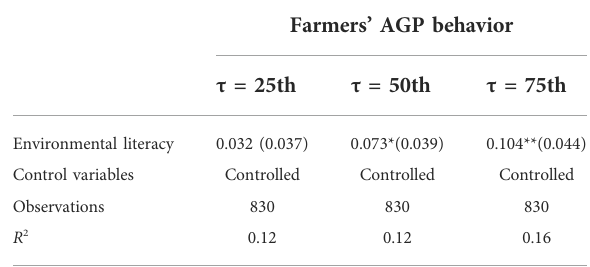
TABLE 12 Quantile regression results.